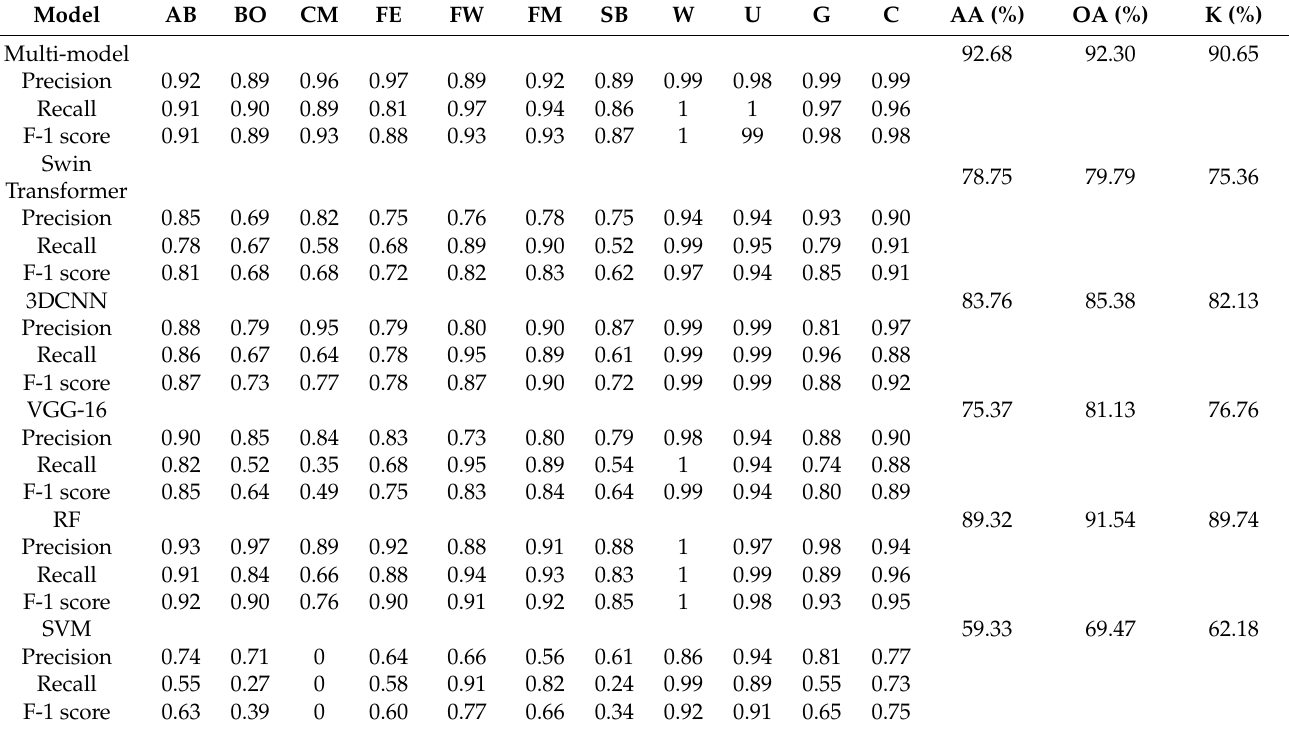
Table 3. Results of the proposed multi-model compared with other classifiers in terms of aver- age accuracy, precision, F1-score, and recall (AB = aquatic bed, BO = bog, CM = coastal marsh, FE = fen, FM = freshwater marsh, FW = forested wetland, SB = shrub wetland, W = water, U =